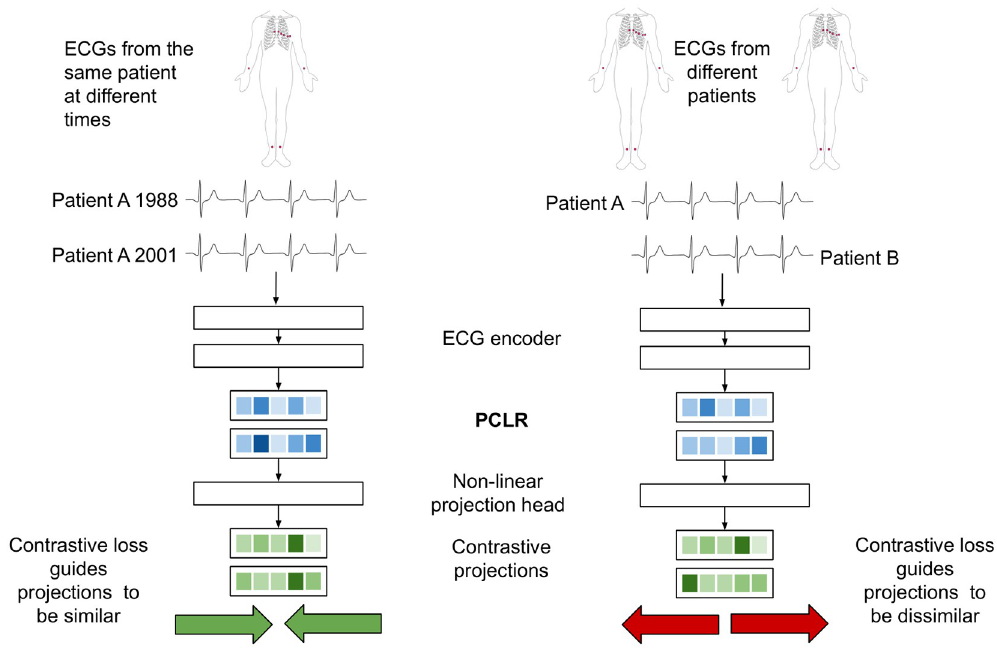
Fig 3. PCLR pre-training procedure for a pair of ECGs from the same patient (left) and from different patients (right).